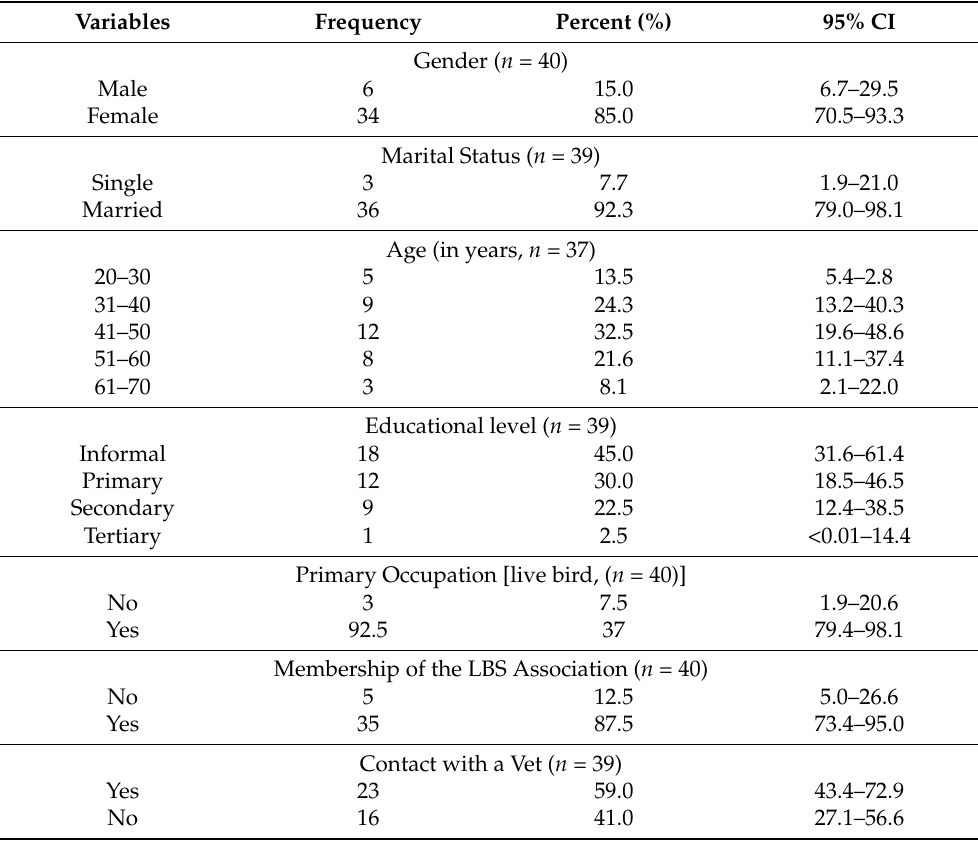
Table 1. Sociodemographic profiles of respondents (LBS) from the eight LBMs investigated in Abe- okuta, Ogun State.